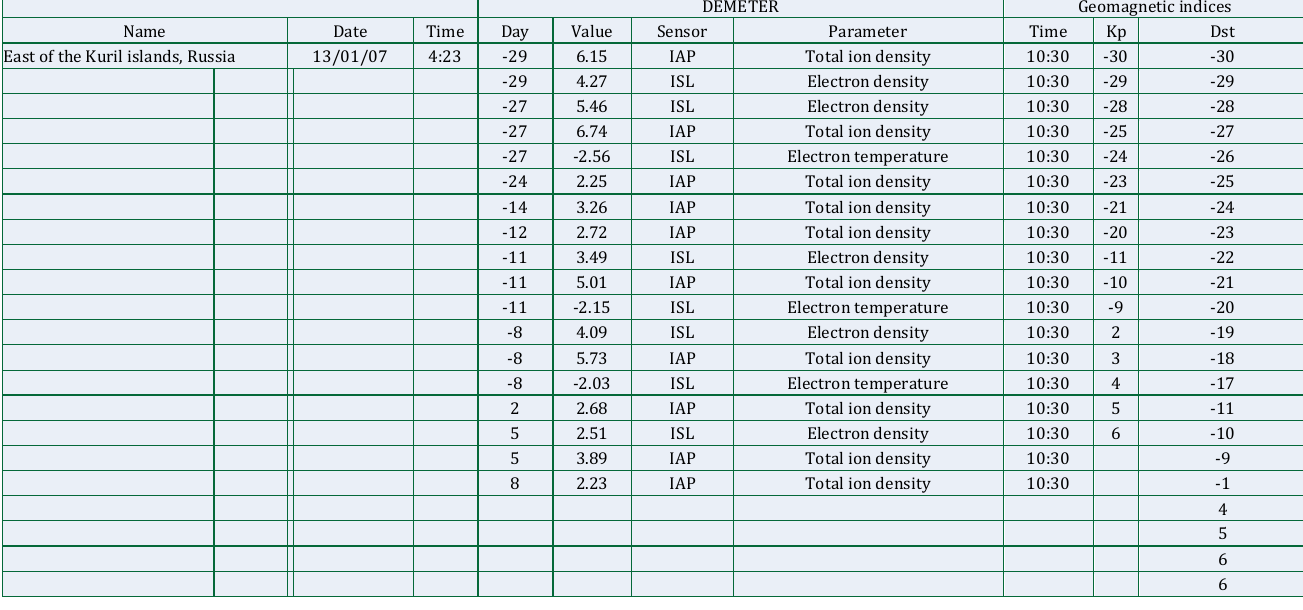
Table 1: List of detected anomaly in the studied seismic event as obtained from the statistical anaysis of DEMETER (IAP and ISL) data correlating with the geomagnetic indices (kp and Dst). Days are relative to earthquake day (13 th January, 2007).